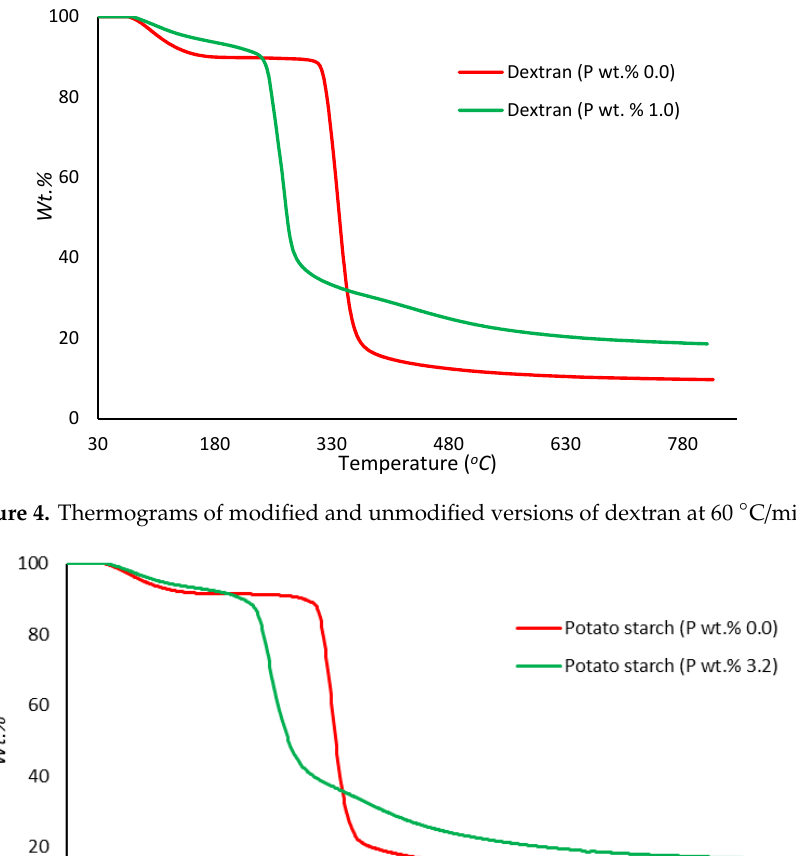
Figure 5. Thermograms of modified and unmodified versions of potato starch at 60 °C/min.